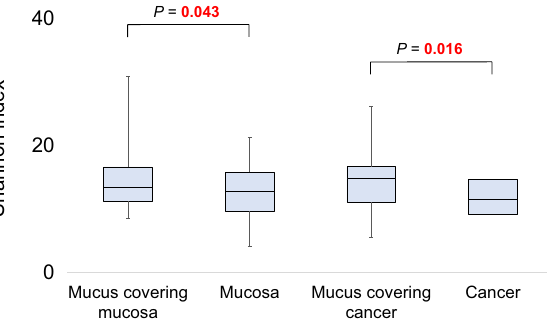
Figure 6. Comparisons of the Shannon index of the mucus covering the mucosa before and after washing, and the mucus covering cancer tissue before and after washing by boxplot. Whiskers are extended to the most extreme data point, which is no greater than 1.5 × the interquartile range from the edge of the box in the boxplot. Statistical significance was determined using the Wilcoxon signed-rank